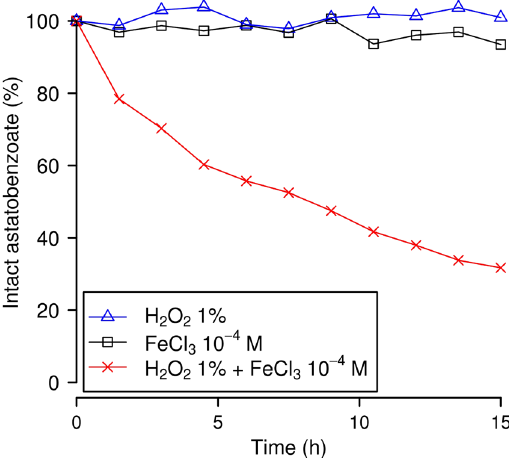
Figure 2. Influence of Fenton-like conditions on the deastatination of the 1a astatobenzoate. Amounts of intact ethyl 3-astatobenzoate are assessed by reverse-phase HPLC coupled to a dual-flow cell gamma detection system 42